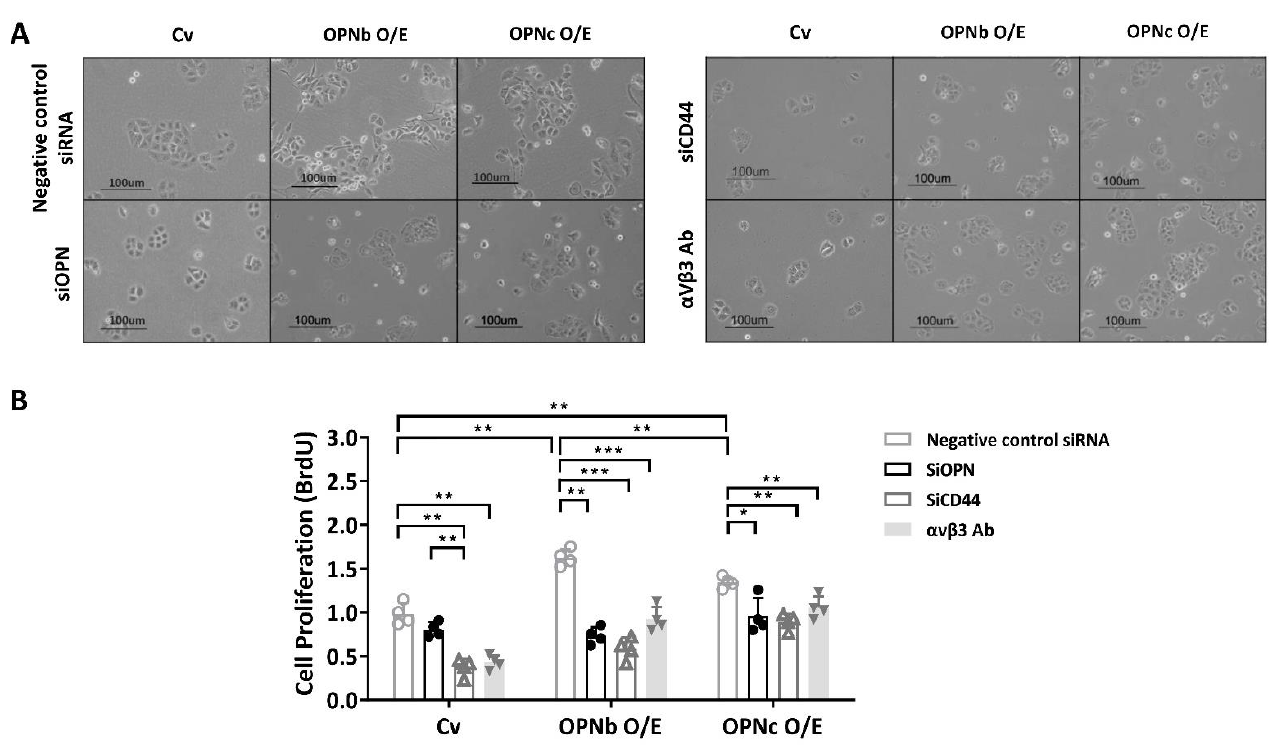
Figure 7. The effect of OPN on cell proliferation in OPN-overexpressing HEC1A cells. ( A ) The OPNb- or OPNc-overexpressing cells showed enhanced proliferation. The morphological change into a slender phenotype similar to the mesenchymal type was also found in the OPN-overexpressing cells. In contrast, through the depletion of OPN and OPN ligand receptors (CD44 and αvβ3), the cell phenotypes resembled those of the control cells. ( B ) The impact of OPN variants on cell proliferation was determined by using the BrdU Cell Proliferation Assay Kit. The results also showed that proliferation was more prominent in OPNb-overexpressing cells than in OPNc-overexpressing and control cells. Plots represent the mean ± SEM, n = 4. Cv: control vector; O/E: overexpression; si: siRNA, αVβ3 Ab: anti - αVβ3 integrin antibody. ( * ) indicates a significant difference with p < 0.05. ( ** ) indicates a significant difference with p < 0.01. ( *** ) indicates a significant difference with p < 0.001.